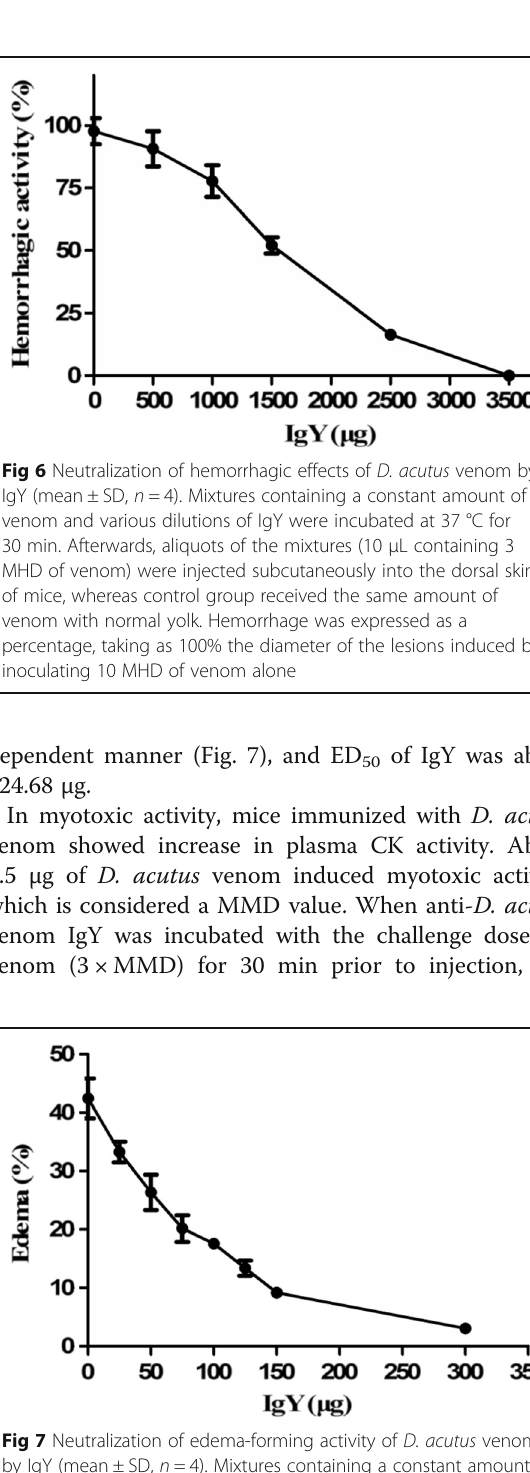
Fig 8 Neutralization of myotoxic activity of D. acutus venom by IgY (Mean ± SD, n = 4). Mixtures containing a constant amount of venom and various dilutions of IgY were incubated at 37 °C for 30 min. Then, aliquots of the mixtures (50 μ L containing 3 MMD of venom) were injected into the right gastrocnemius muscle of mice, whereas control group received 50 μ L of physiological saline. CK activity was expressed in